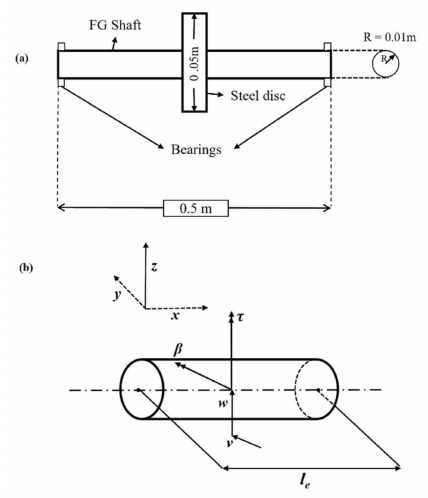
Figure 3. ( a ) An FG rotor–bearing system. ( b ) A porous FG shaft